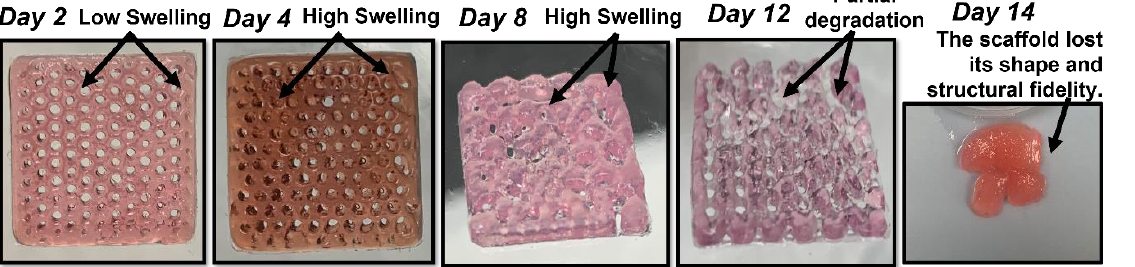
Figure 8. Digital images showing the swelling nature of the A12-G6 printed scaffolds (20 × 20 × 1 mm 3 ) over time. The scaffolds were incubated in DMEM at 37 °C over 14 days. The scaffolds first gained weight, but then after 9 days, they started degrading.